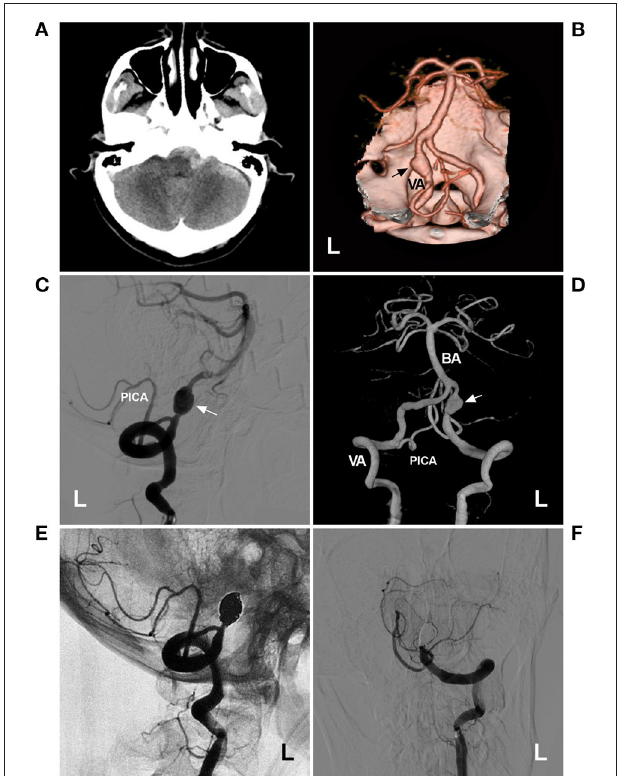
FIGURE 5 | PAO for a VA acute fusiform aneurysm. (A) CT showed subarachnoid hemorrhage in front of the brainstem. (B) CTA showed a fusiform aneurysm (arrow) on the left VA. (C) DSA of the left VA showed the aneurysm (arrow) above PICA origin. (D) Three-dimensional DSA showed the aneurysm (arrow), and the contralateral VA was normally developed. (E) Unsubtracted DSA showed that the aneurysm was treated with PAO, and the PAO was intact. (F) Half-year follow-up DSA showed no recurrence of the aneurysm.BA, basilar artery; CT, computed tomography; CTA, computed tomography angiography; DSA, digital subtraction angiography; L, left; PICA, posterior inferior cerebellar artery; VA, vertebral